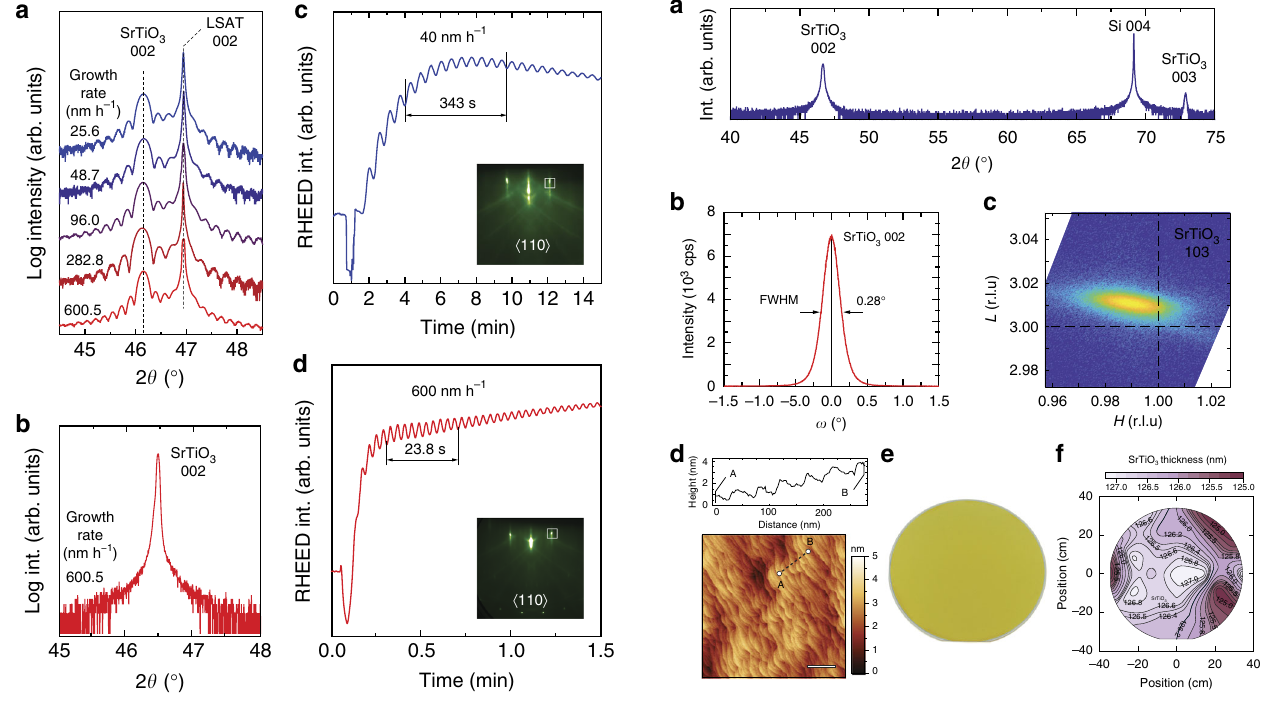
Fig. 4 X-ray diffraction and RHEED oscillation. a High resolution 2 θ – ω X-ray scans of the 002 (La 0.18 Sr 0.82 )(Al 0.59 Ta 0.41 )O 3 (LSAT) substrate (~46.9°) and SrTiO 3 fi lm peaks (~46.2°) for growth rates ranging from 25.6 to 600.5 nm h − 1 . b 2 θ – ω X-ray scan of the 002 peak for a 500-nm-thick SrTiO 3 fi lm grown homoepitaxially at 600 nm h − 1 . c, d Re fl ection high- energy electron diffraction (RHEED) intensity oscillation of the 10 diffraction streak (see inset) for SrTiO 3 fi lms grown on LSAT at 40 and 600 nm h − 1 . The sharp RHEED intensity drop is caused by the sample shutter operation needed to start the growth, blocking the electron from optical inspection (Fig. 5e) and the SrTiO 3 fi lm thickness scopic ellipsometry, see Fig. 5f. A less than 1% change in SrTiO 3